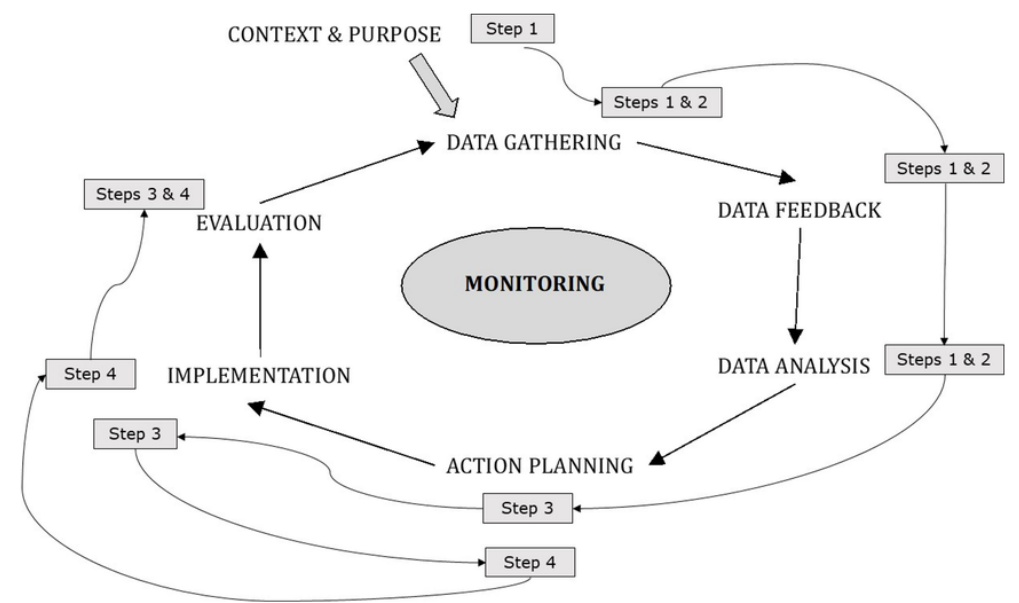
Figure 5. Action research cycle steps (Coughlan & Coghlan, 2002) and link to systematic process developed by authors